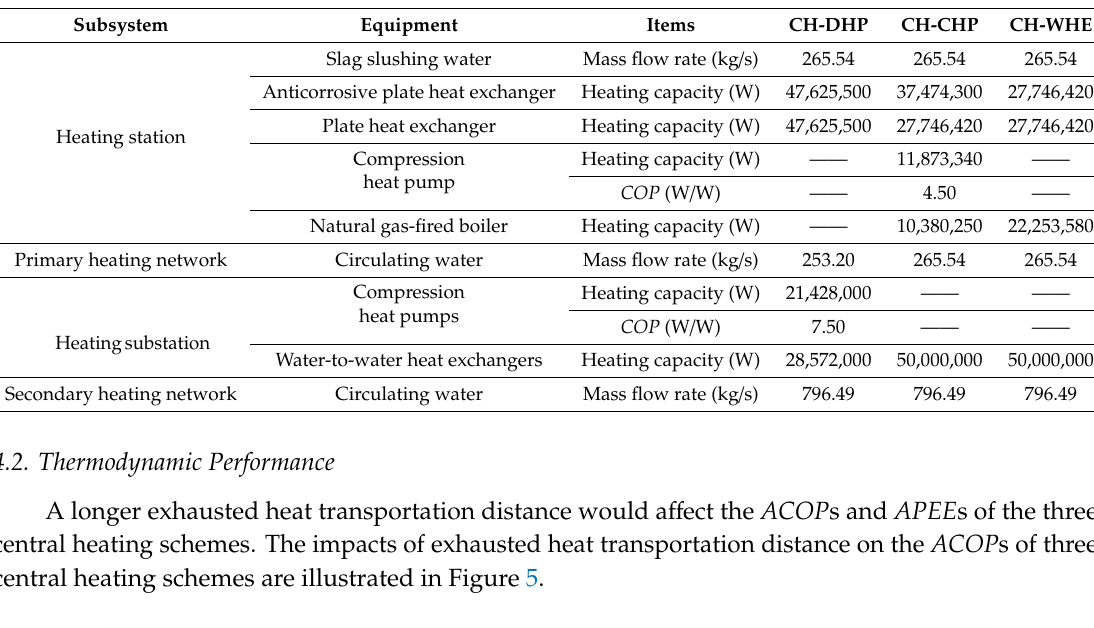
Table 1. Main thermal parameters of the three central heating systems.